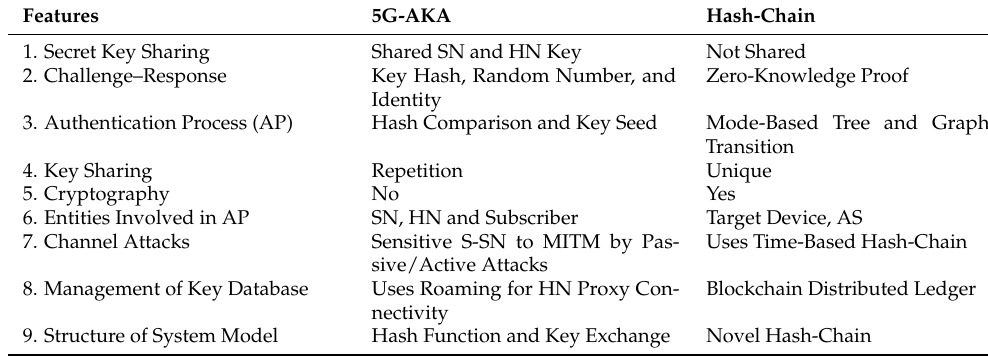
Table 6. 5G AKA protocol comparison.